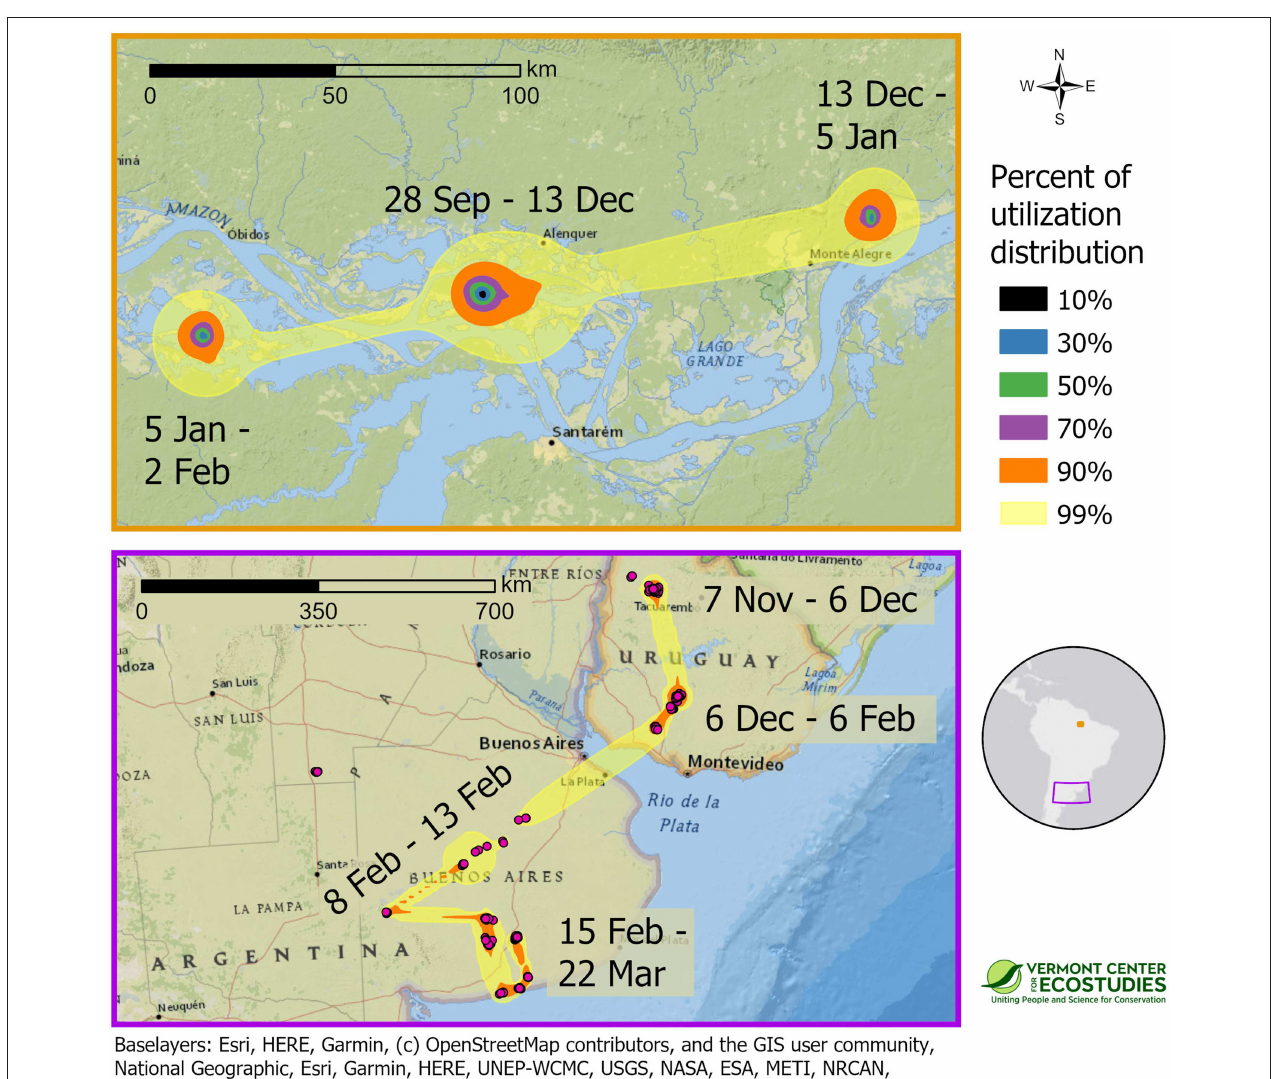
FIGURE 5 | Space use of two Upland Sandpipers, tracked with PTT transmitters, at non-breeding sites in South America during the winter of 2016–2017. One sandpiper from Massachusetts wintered on a network of islands along the Amazon River in Brazil (WO-PTT-68, Top ), whereas one sandpiper from Kansas overwintered in Uruguay and northern Argentina (KO-PTT-66, Bottom ). Approximate 99% utilization distributions indicate probability of use for each sandpiper during the non-breeding period, and were calculated using dynamic Brownian bridge movement models. Note that scale bars differ between the two panels. Border color of the panels indicates their location on the inset map. Note the difference in scales between the two